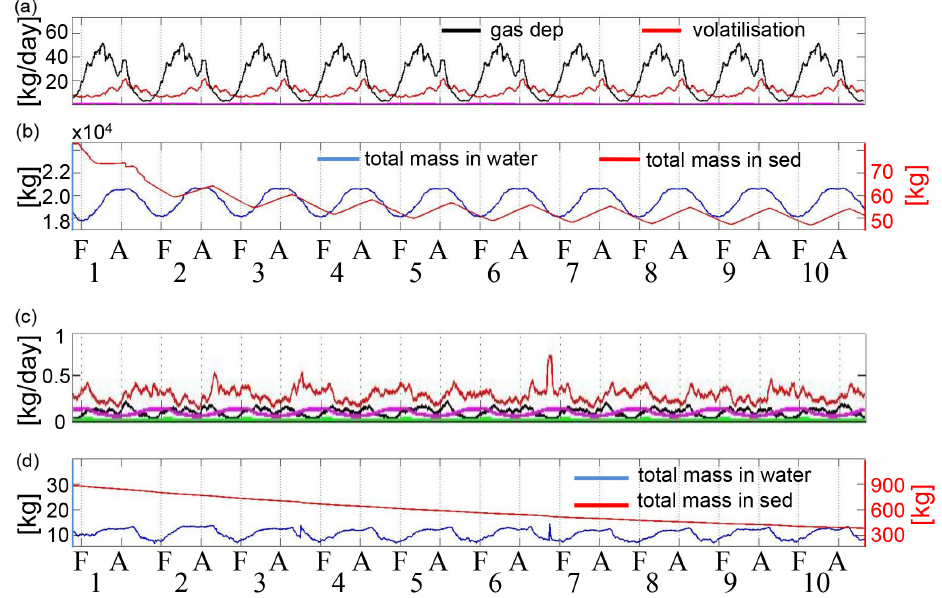
Figure 3. Time series of surface fluxes and total mass in water and sediment of γ -HCH, top two panels, respectively, and the same for PCB 153, bottom two panels, respectively, for the period 2006–2015. February and August (F and A) and the year number (1–10) are shown on the x axis. River input, wet deposition and dry deposition are plotted in magenta, green and blue (panels 1 and 3), respectively. Note the different scales (on the left and right) in second and bottom panels showing the different amounts of the substance in water and